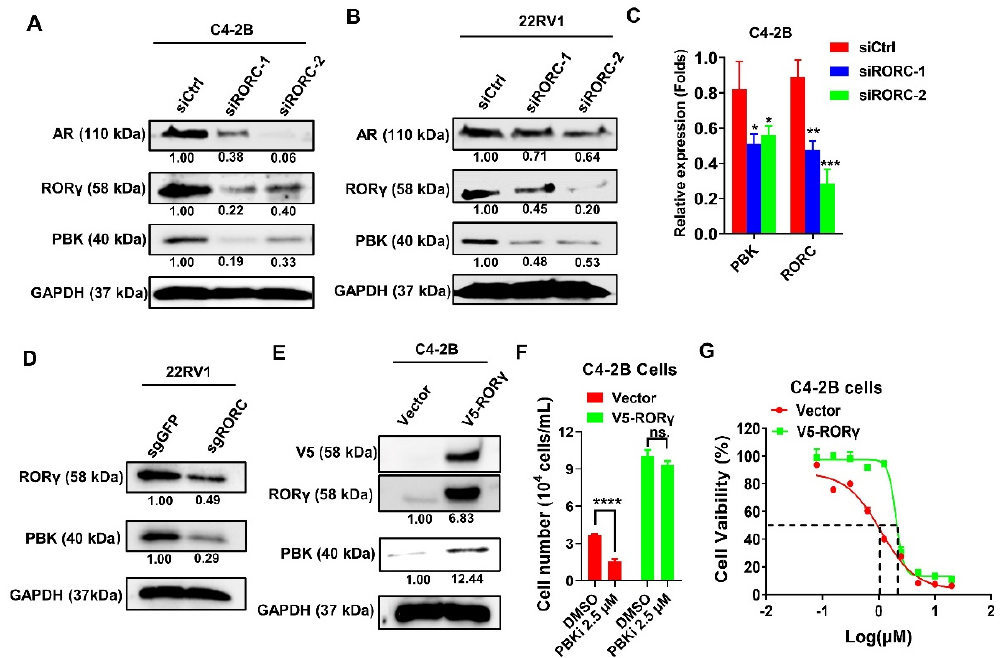
Figure 4. PDZ-binding kinase (PBK) is a downstream gene regulated by ROR γ . ( A , B ) Western blotting analysis of C4 − 2B cells and 22Rv1 cells transfected with RORC siRNAs for 72 h. ( C ) qRT − PCR analysis of PBK and RORC mRNAs in C4 − 2B cells transfected with the siRNAs. ( D , E ) Western blotting of 22Rv1 or C4 − 2B cells infected with lentiviruses expressing CRISPR − Cas9 and sgRNA − RORC ( D ) or V5 − ROR γ ( E ) respectively or the control viruses for 72 h. ( F ) C4 − 2B cells were infected with lentiviruses expressing V5 − ROR γ or the control for 24 h and then treated with 2.5 μ M PBKi for another 72 h before cell number was counted. ( G ) C4 − 2B cells were infected with lentiviruses expressing V5 − ROR γ or empty vector for 24 h and then detached and seeded to 96-well plates at 1500 cells per well. After 24 h recovery, cells were treated with increasing doses of PBKi for another 72 h before subject to cell viability measurements. Density of bands was measured and presented as in Figure 1. Results are presented as mean ± SD. * p < 0.05, ** p < 0.01, *** p < 0.001, **** p < 0.0001.